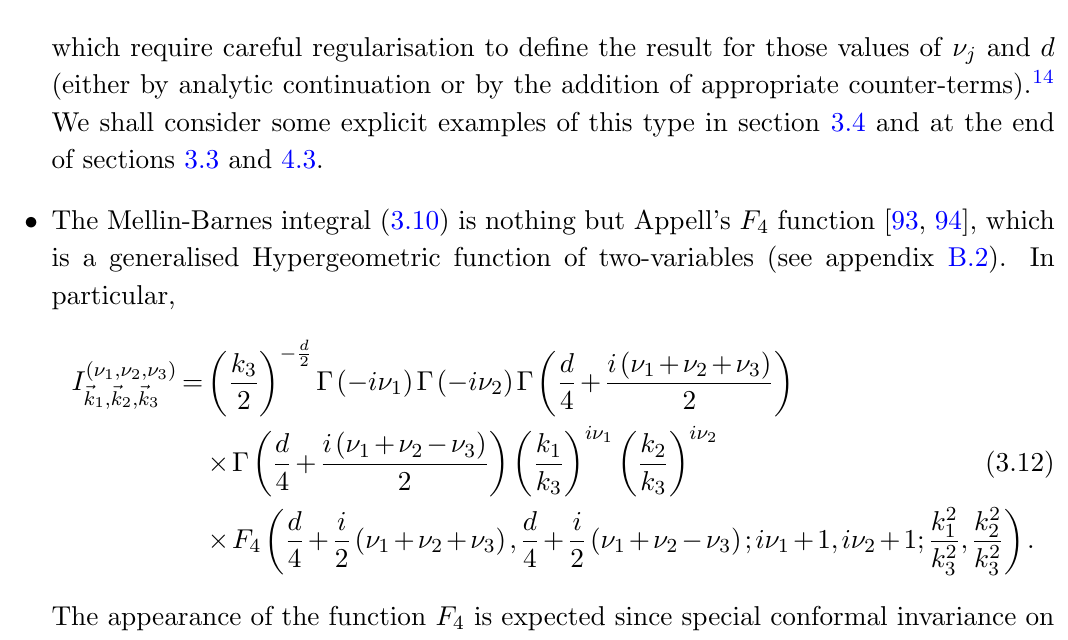
Figure 4. Integration contour (Green) for the Mellin-Barnes representation (3.10) of the three- point conformal structure. W.l.o.g. we focus on the integral in the Mellin variable s 2 and take Re ( s 1 ) = 0. In this (cid:12)gure all scaling dimensions are taken to lie on the Principal Series (2.5), (cid:23) j 2 R . (cid:0) (cid:1) Poles of the (cid:0)-functions (cid:0) s 2 (cid:6) i(cid:23) 2 are displayed in red and the poles of (cid:0) 2 blue, which the integration contour is prescribed to